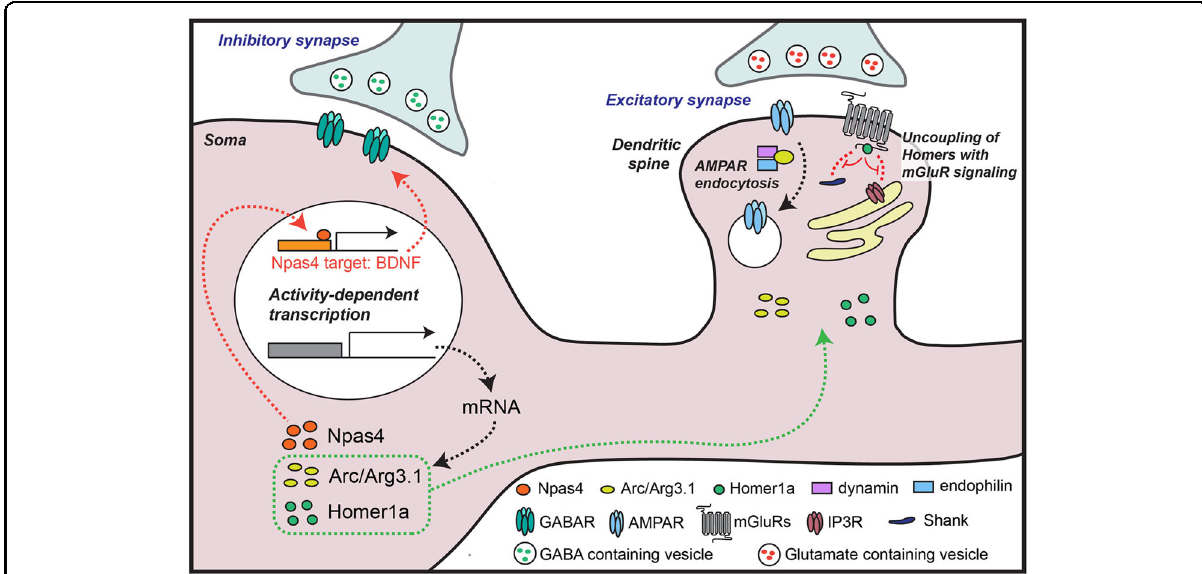
Fig. 1 Distinct actions of Arc , Npas4 , and Homer1a at excitatory and inhibitory synapses. Neuronal activation induces rapid transcription of immediate-early genes (IEGs) such as Npas4 , Arc , and Homer1a . Npas4 regulates the transcription of its downstream target genes including BDNF to regulate inhibitory synapse development. Arc is targeted to activated excitatory synapses and facilitates AMPA receptor endocytosis through interaction with dynamin and endophilin, resulting in long-term depression. Homer1a is also speci fi cally targeted to excitatory synapses, where it competes with other Homer proteins to interact with Homer-binding proteins such as mGluRs, Shanks, and IP 3 R and negatively acts in regulating excitatory synapse structure, function, and